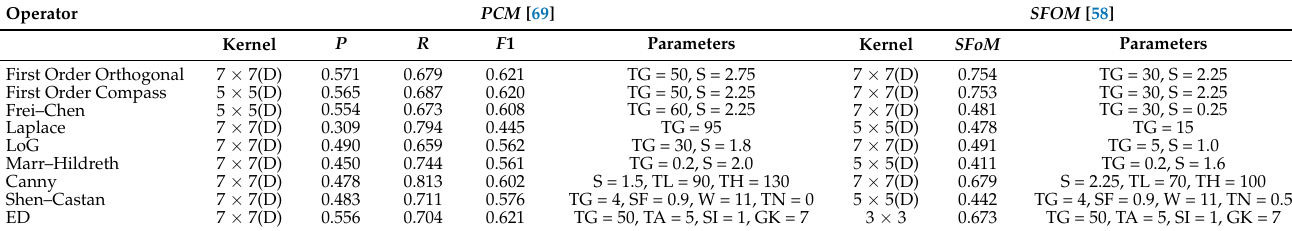
Table 1. Overall best results for each edge operator